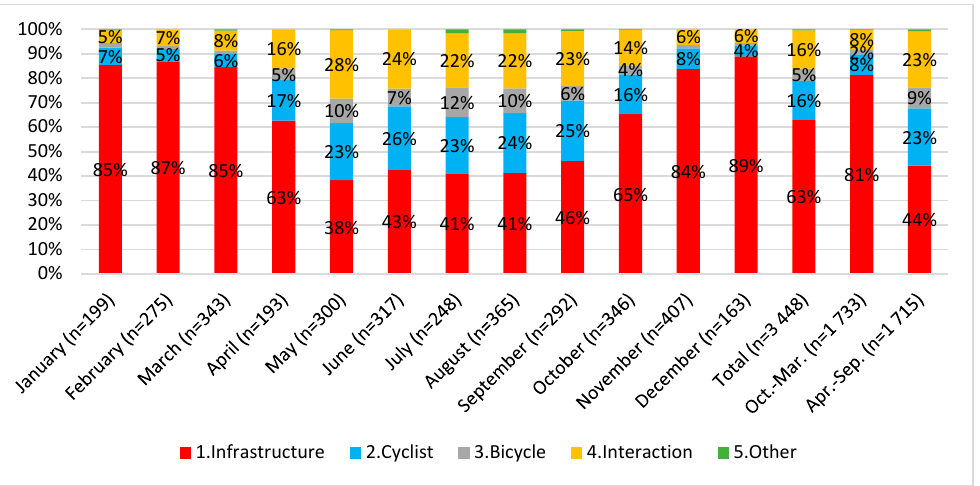
Figure 2. The number of crashes and the share of the main characteristics in each month.